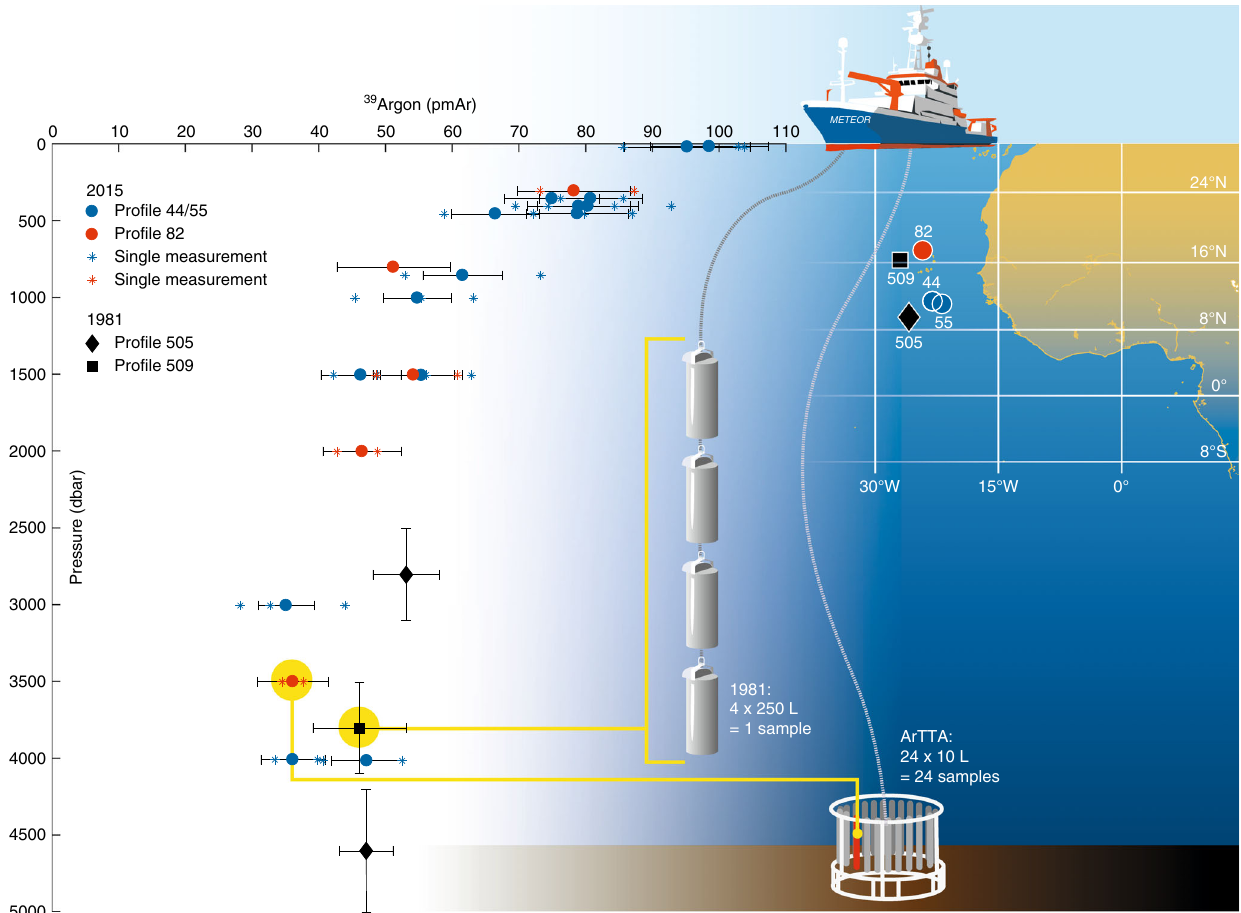
Fig. 1 39 Ar/Ar ratios in percent of modern Argon (pmAr) for different depths in the Eastern Tropical North Atlantic (blue and red dots). Each sample was analysed with at least two independent measurements and the horizontal error bars represent the uncertainties of the combined single measurements (single stars). The sensitivity and ef fi ciency of ArTTA allows for a full-depth pro fi le from just one CTD cast corresponding to sample sizes as small as 5 L of water. For comparison, three historic (1981) data points 11 from two speci fi c sites are included (black square and rhombi); the required 1000 L for LLC analysis was obtained by combining four 250 L sampling bottles integrating over a depth range of 600 to 800 m (vertical error bars). The map shows the western part of Africa and the sampling stations of this study and those from 1981 around the archipelago of Cape